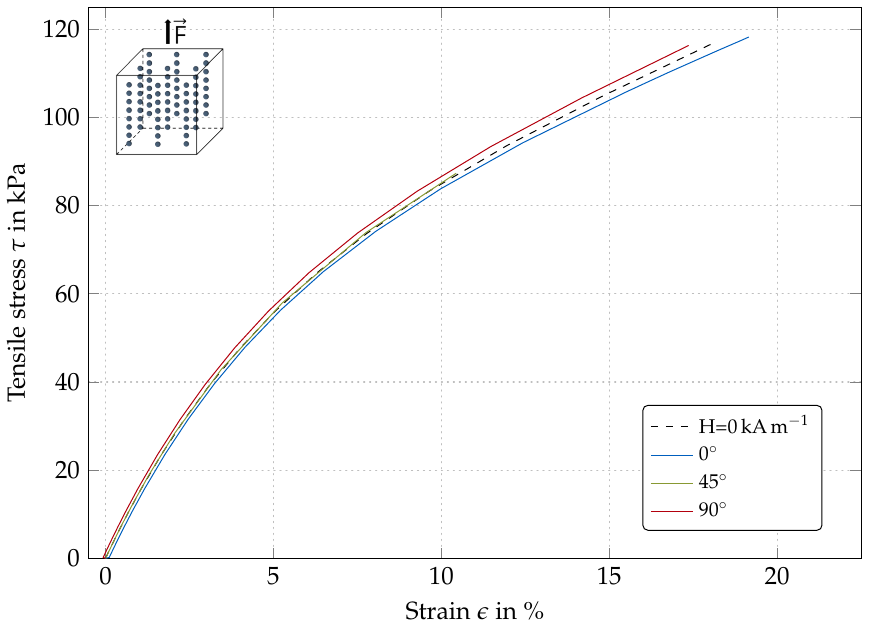
Figure 5. Simulated stress–strain behavior of an anisotropic MR elastomer with pre-structuring directions parallel to direction of force application for different magnetic field orientations (H = 30kAm − 1